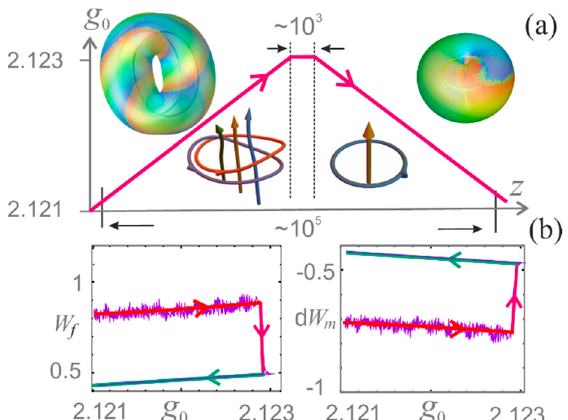
Figure 17. ( a ) Cycle of variation of small-signal gain g 0 (red trapezoidal line). Inserts: isointensity surfaces and skeletons for “Hopf + ” (left, increase of g 0 ) and “apple” (right, decrease of g 0 ) solitons. ( b ) Variation of the field energy W f (left) and energy of the medium dW m (right) during increase (red) and decrease (green) of g 0